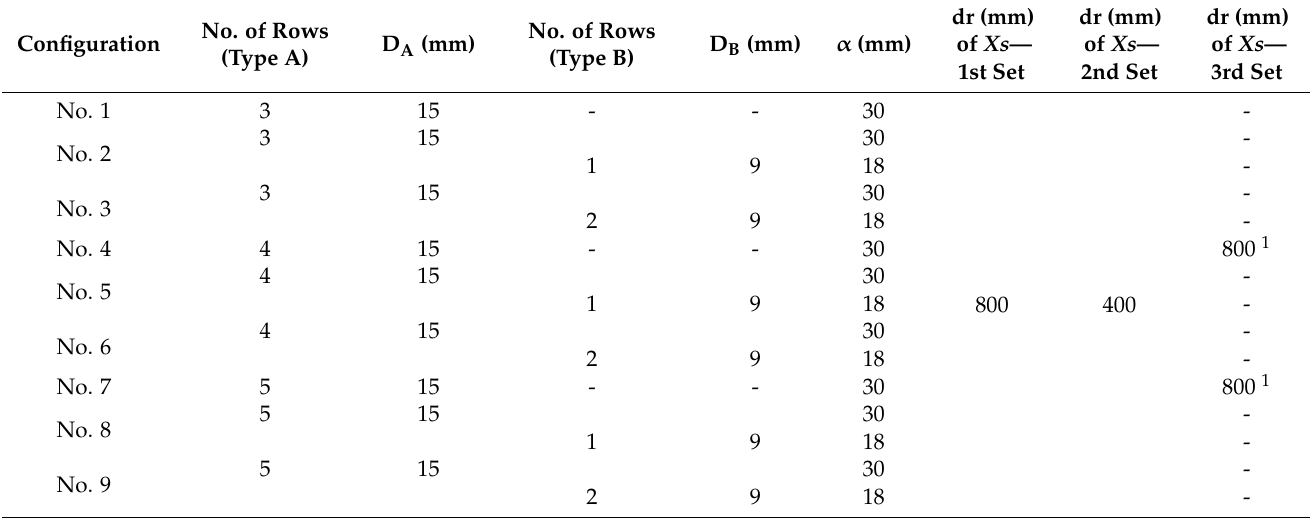
Table 1. Description of all the configurations assumed during the acoustic measurements. D is the scatterer diameter, α is the lattice constant, dr is the distance from the edge of the barrier.